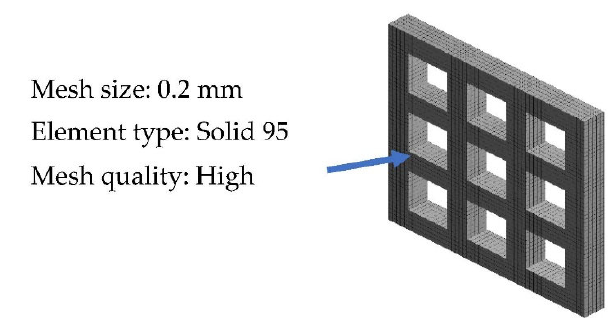
Figure 3. Meshing of the scaffold model.